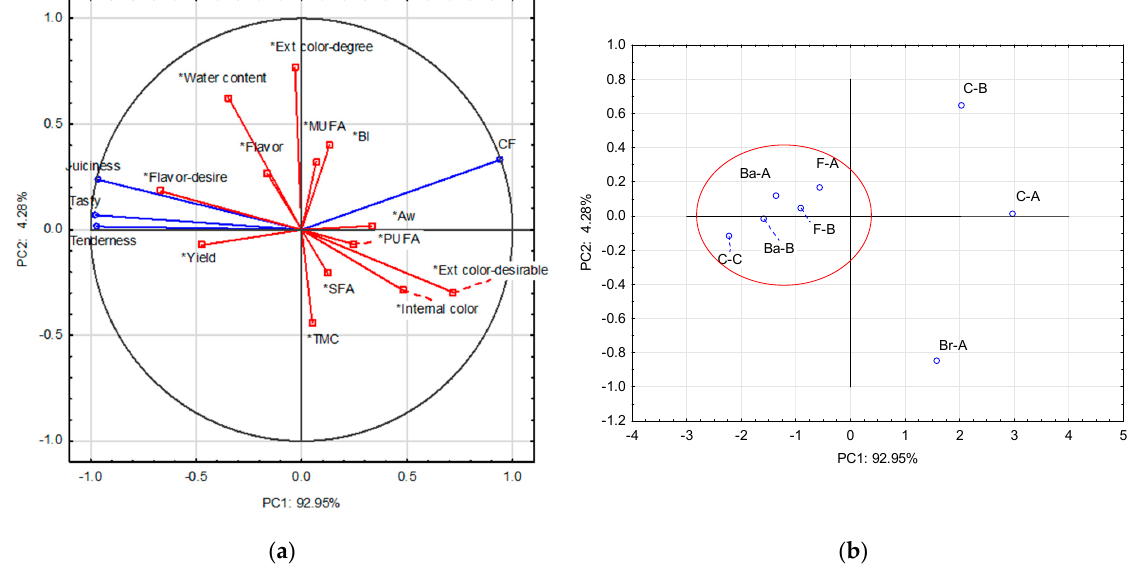
Figure 4. Similarities and di ff erences (PCA) in the sensory quality of chicken breast fi llet samples: ( a ) projection of the assessed sensory characteristics, ( b ) projection of di ff erences and similarities in the sensory quality of chicken breast fi llet, depending on the heat treatment used and the heating group. Code designations as in Table 1. TMC—total microbial count, Aw—water activity, BI— browning index.